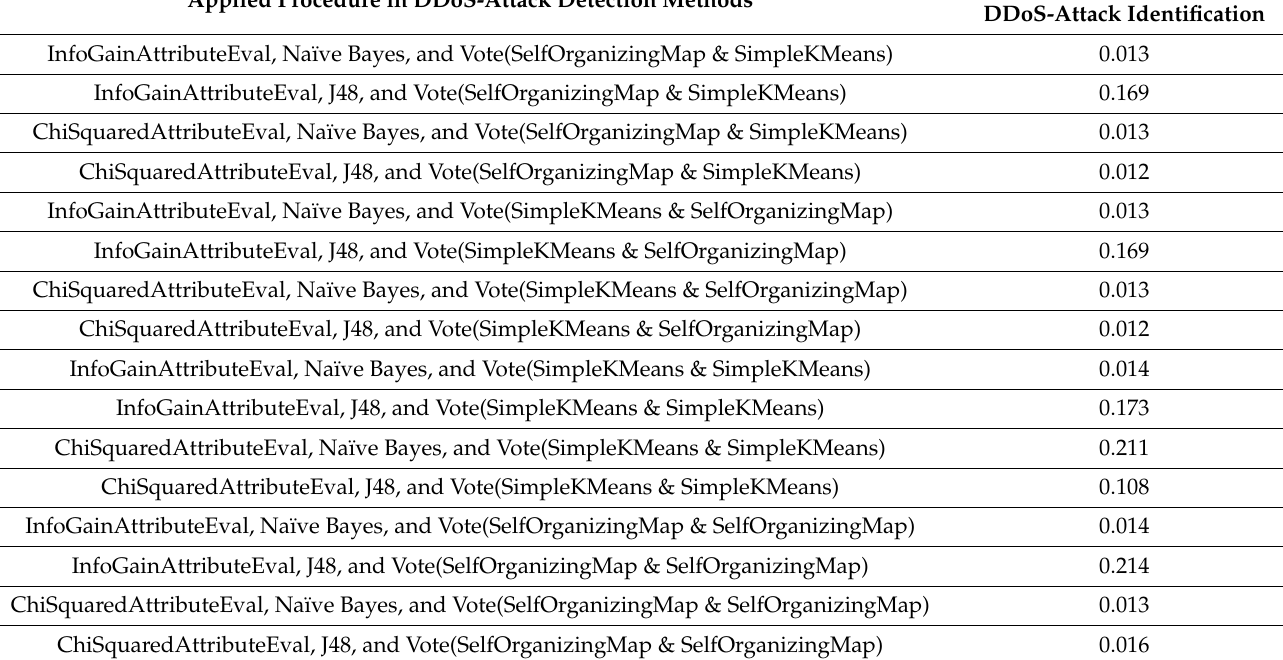
Table A4. False-positive rates using the wrapper method. Applied Procedure in DDoS-Attack Detection